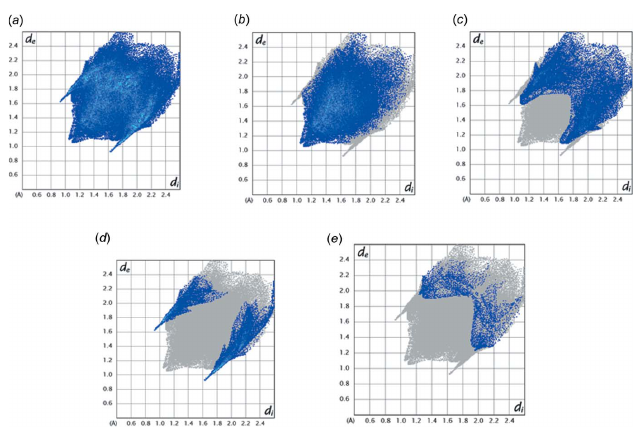
Figure 5 Fingerprint plots showing all ( a ) interactions and resolved into ( b ) H (cid:2)(cid:2)(cid:2) H, ( c ) H (cid:2)(cid:2)(cid:2) C/C (cid:2)(cid:2)(cid:2) H, ( d ) Br (cid:2)(cid:2)(cid:2) H/H (cid:2)(cid:2)(cid:2) Br and ( e ) S (cid:2)(cid:2)(cid:2) H/H (cid:2)(cid:2)(cid:2) S